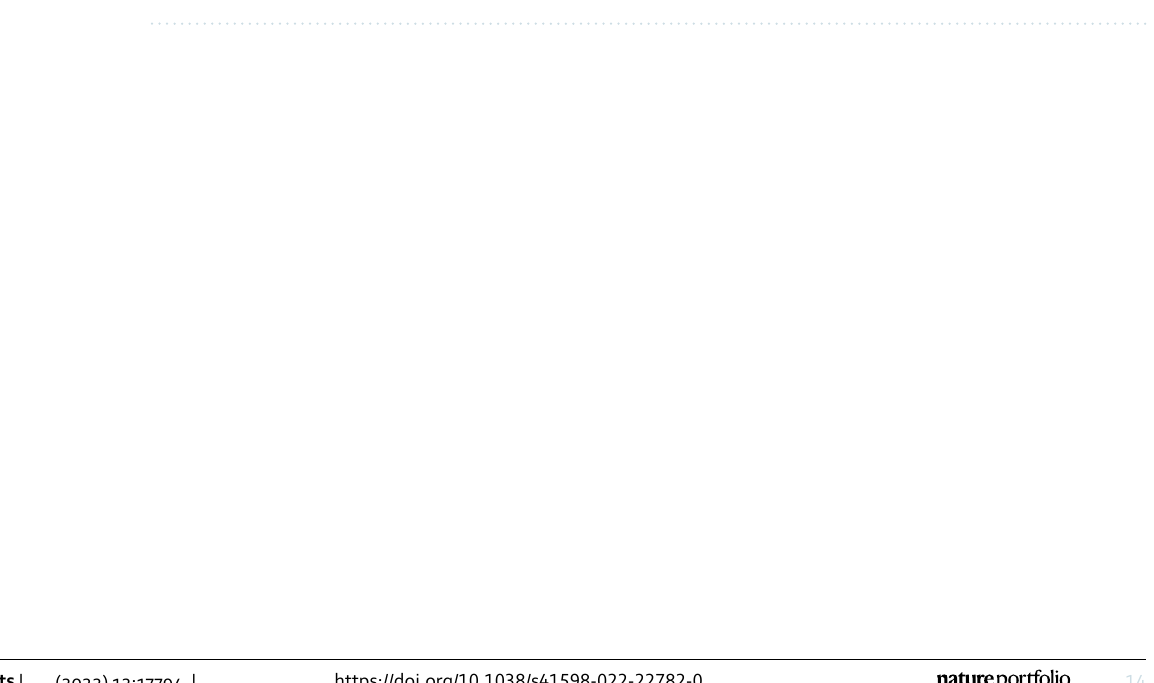
Figure 11. Streamline and isotherm contours for the number of waves N, for numerous Ra* values at ϕ = 0.01 ε = 0.6 Da = 10 –4 kr = 1 A = D =